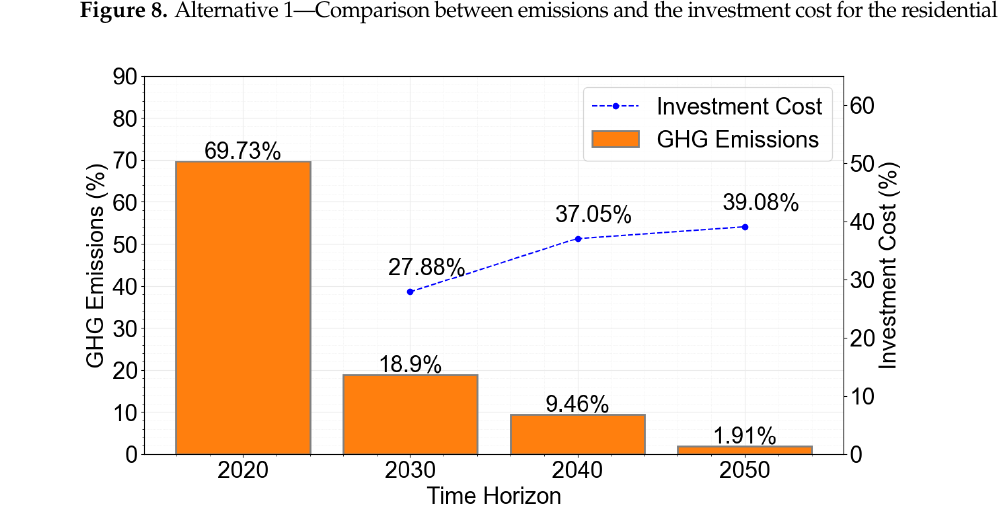
Figure 8. Alternative 1—Comparison between emissions and the investment cost for the residential sector.